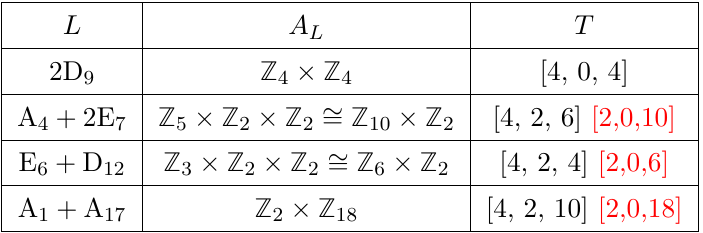
Examples of allowed L with ‘ ( A L ) = 2, when d = 2. The candidates for T with d ( T ) = d ( L ), but with ( A T ; q T ) (cid:29) ( A L ; q L ), are displayed in